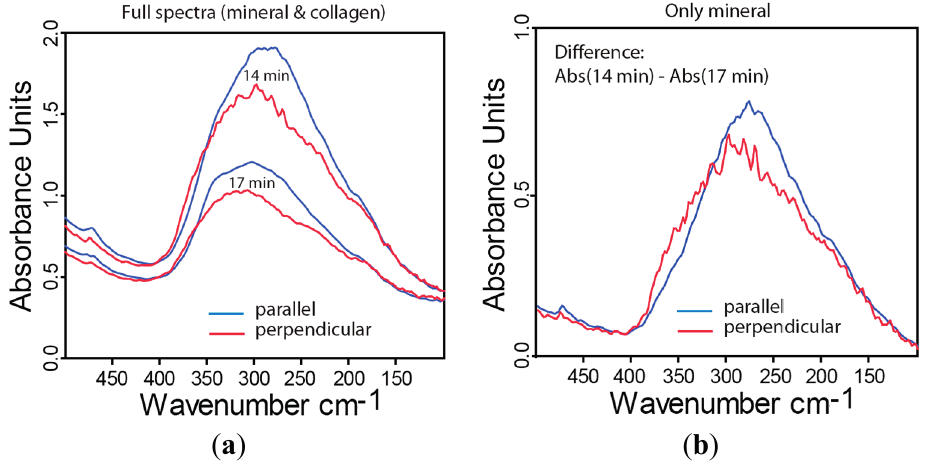
Figure 4. Far-IR dichroism measurements of bovine fibrolamellar bone showing the absorbance parallel ( blue ) or perpendicular ( red ) to the long axis of the bone. ( a ) Spectra obtained after two different time intervals of demineralization (14 and 17 min total time in EDTA); ( b ) Calculated spectra after subtracting the contribution of collagen (see text